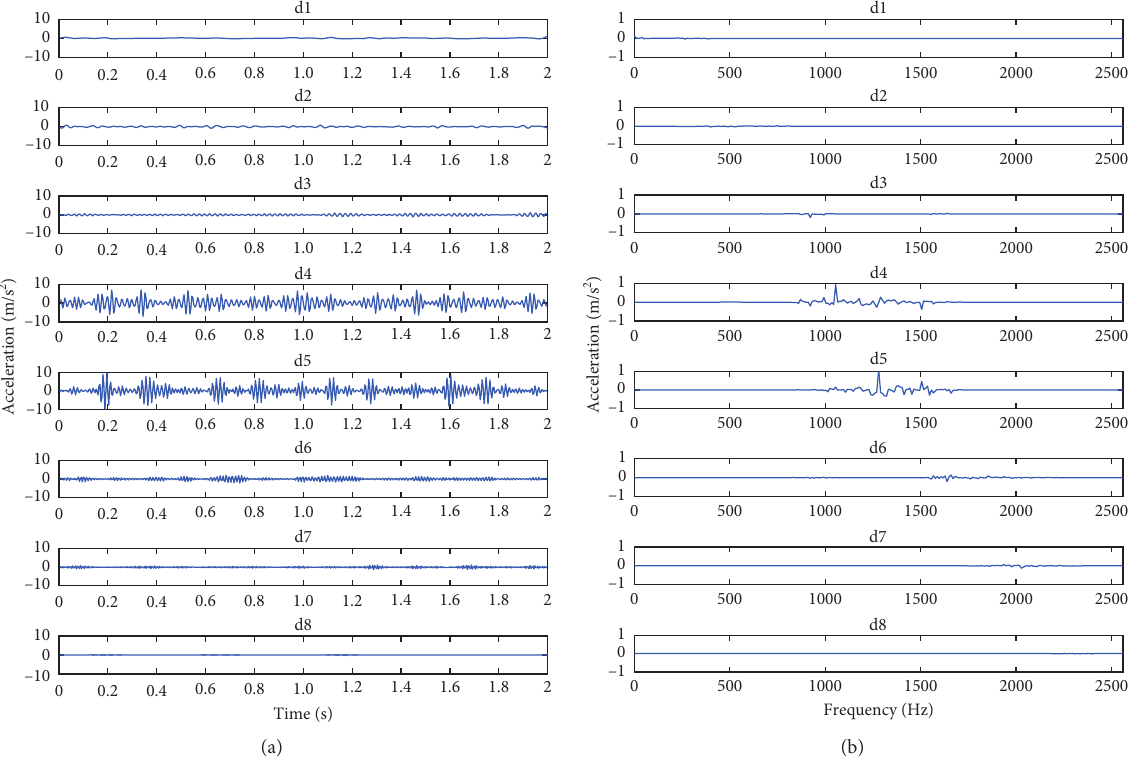
Figure 8: The reconstructed signal of each frequency band and their amplitude spectrum in the chatter